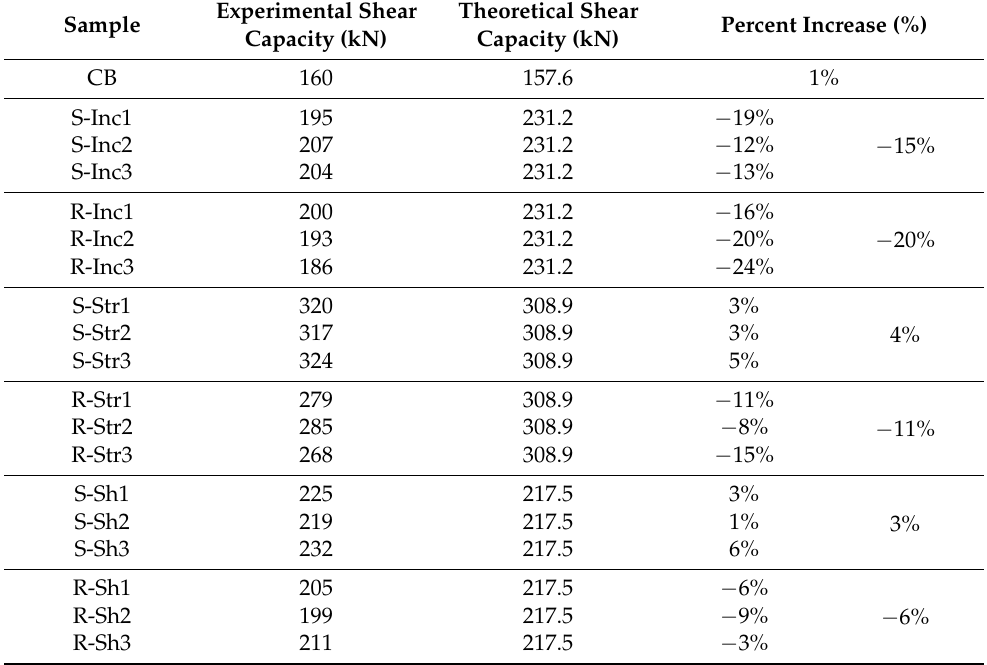
Table 9. Comparison between experimental and theoretical shear capacity